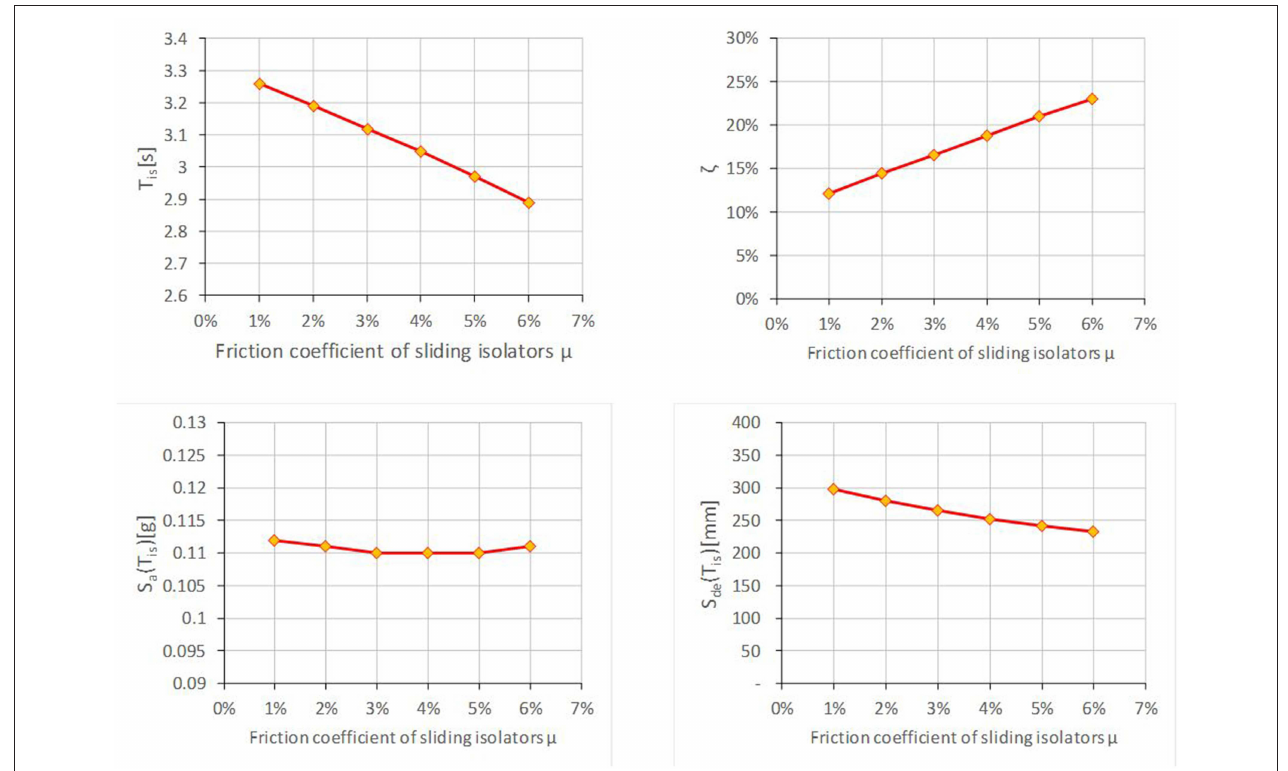
FIGURE 11 | Base-isolated model. Shapes and dynamic properties of the first three vibration modes.